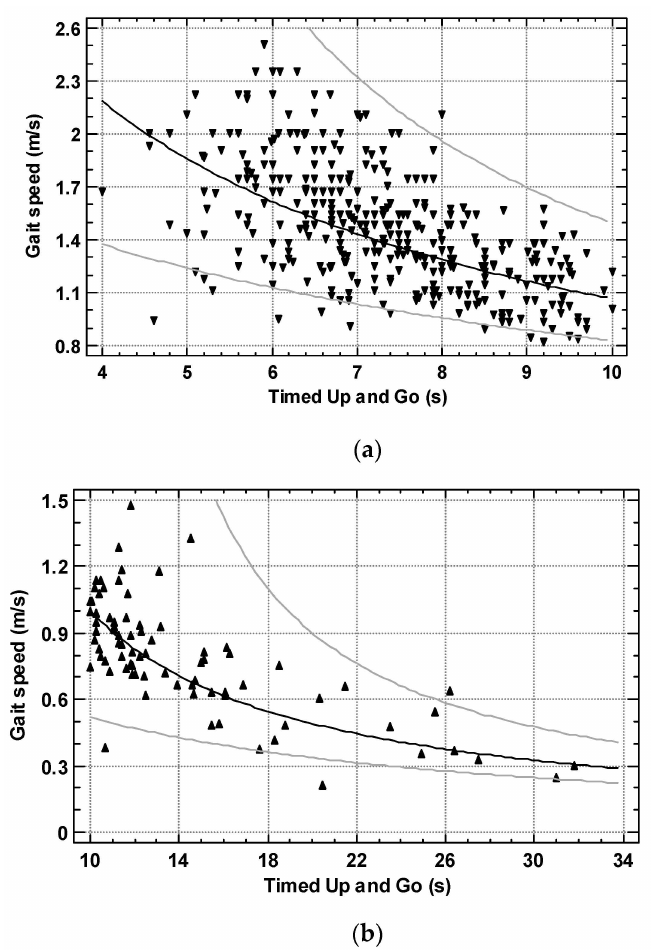
Figure 2. ( a ) the relationship of Timed Up and Go to gait speed in 368 subjects with TUG ≤ 10 s (regression line, 95% prediction limits); ( b ) the relationship of Timed Up and Go to gait speed in 82 subjects with TUG > 10 s (regression line, 95% prediction